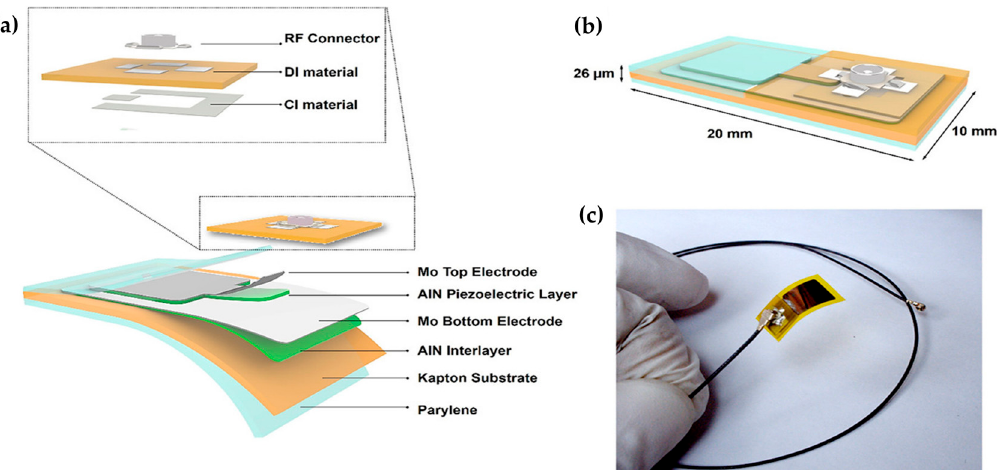
Figure 18. Illustration of the different layers constituting the sensor, and in the box, the representation of the connection package made by 3D printing ( a ). Illustration of the sensor’s shape and dimensions ( b ). Photograph of the resulting sensor connected with a coaxial cable ( c ) [20].